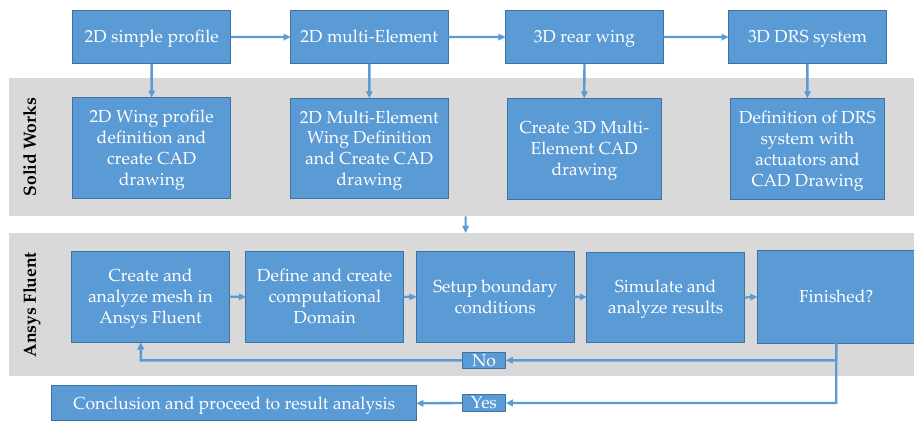
Figure 1. Flowchart with the geometries analyzed and software used.